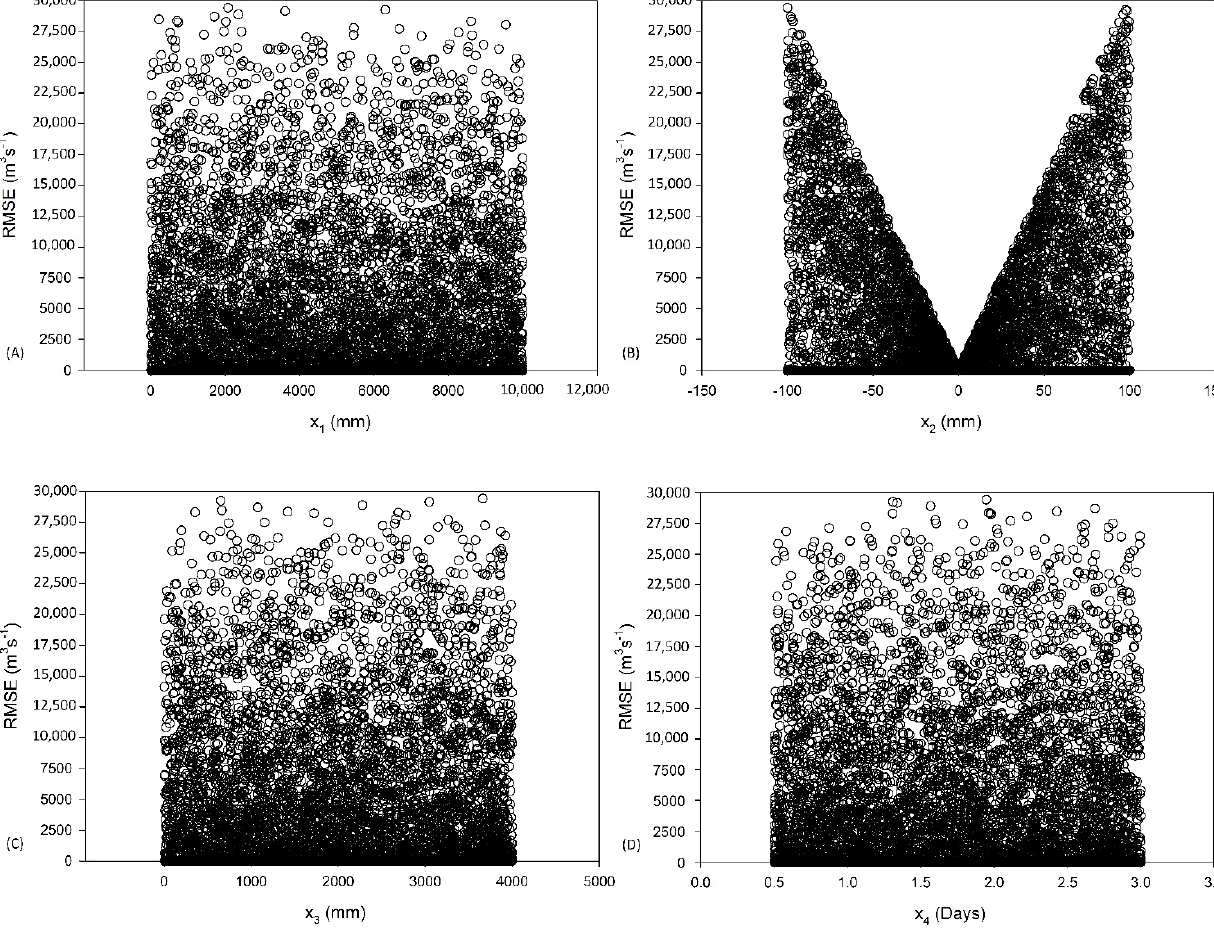
Figure A3. Scatter graphs between RMSE efficiency statistic ( Y -axis) and parameter values: ( A ) X 1 , ( B ) X 2 , ( C ) X 3 , ( D ) X 4 , ( E ) X 5 and ( F ) X 6 , for hydrological model GR6J.